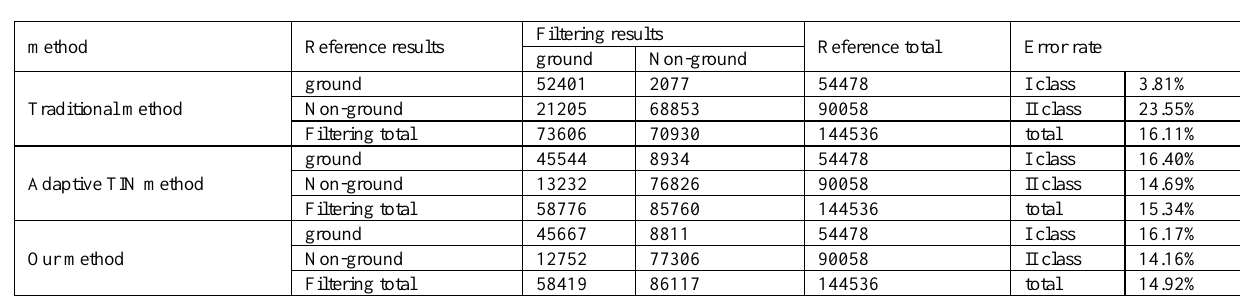
Table 4. Filtering results of mountain